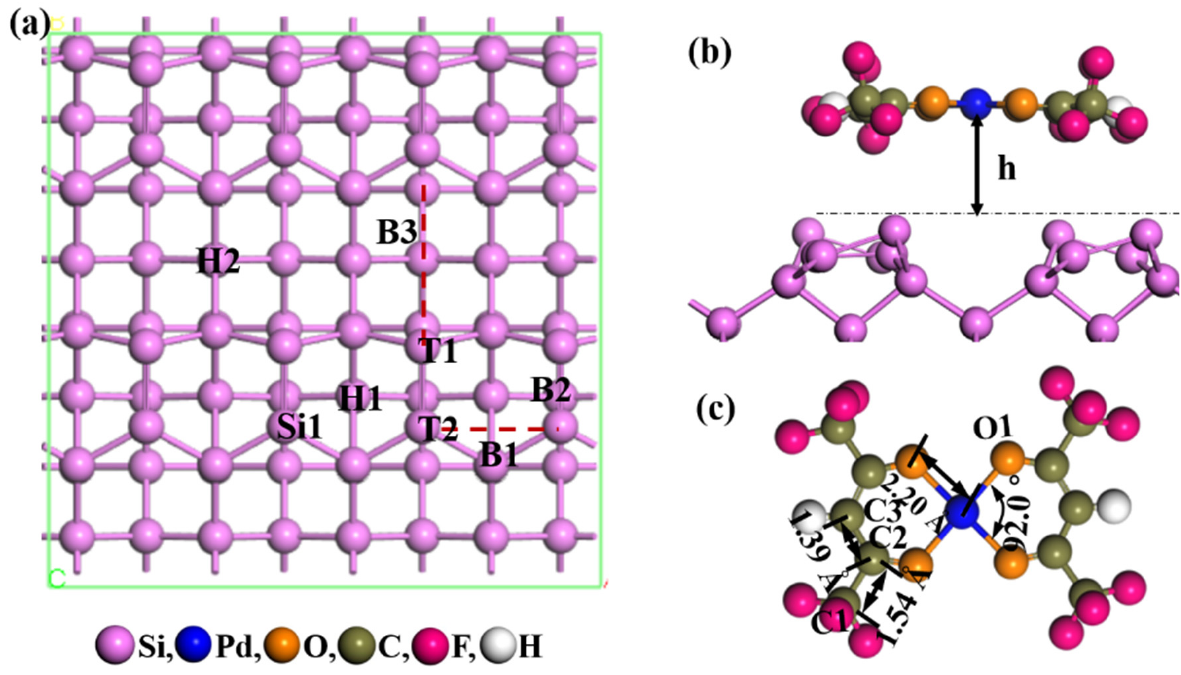
Figure 1. ( a ) The surface of the obtained clean Si (100) after geometry optimization, ( b ) the structure of clean Si (100) with a Pd(hfac) 2 (h0 = 3.0 Å), and ( c ) the obtained Pd(hfac) 2 after geometry optimization.